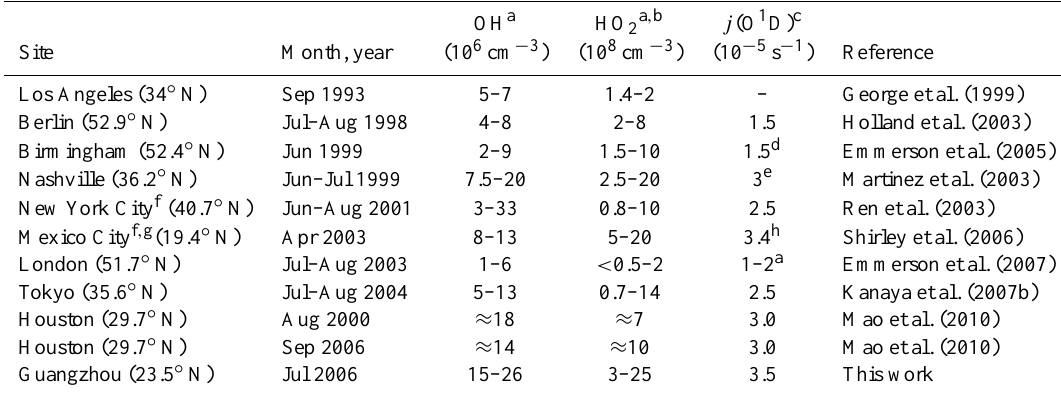
Table 6. Noontime maxima of measured HO x concentrations at urban and suburban sites during summer time. All the cited radical measurements were performed by LIF